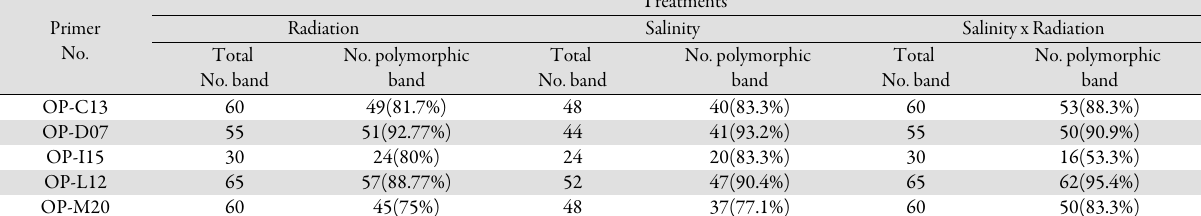
Table 4. RAPD patterns generated for haploid Nicotiana alata under different treatments